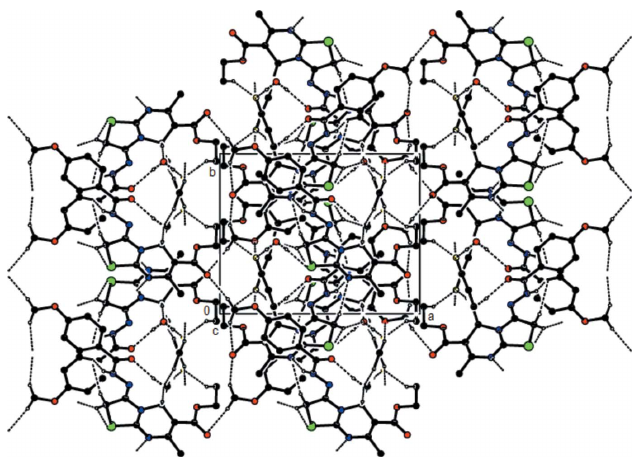
Figure 4 View of the molecular packing along [001]. Hydrogen bonds are depicted as in Fig.